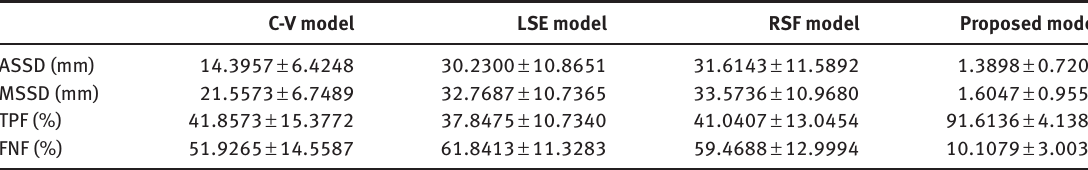
Table 1: Average ASSD, MSSD, TPF and FNF for the Proposed Models and Existing